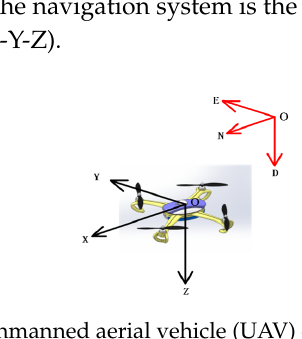
Figure 1. Unmanned aerial vehicle (UAV) coordinate